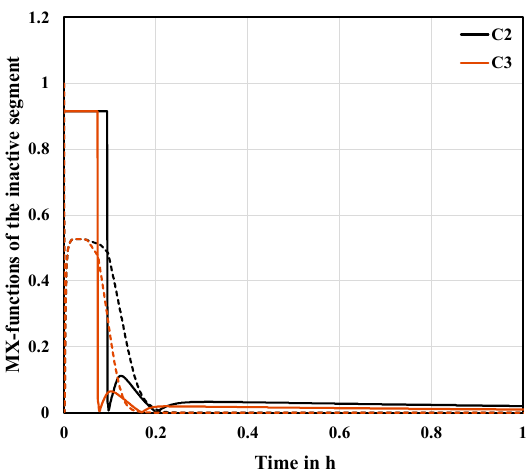
Figure 9. MX-functions at the top (solid line) and bottom (dashed line) of the inactive segment for cases C2 and C3.